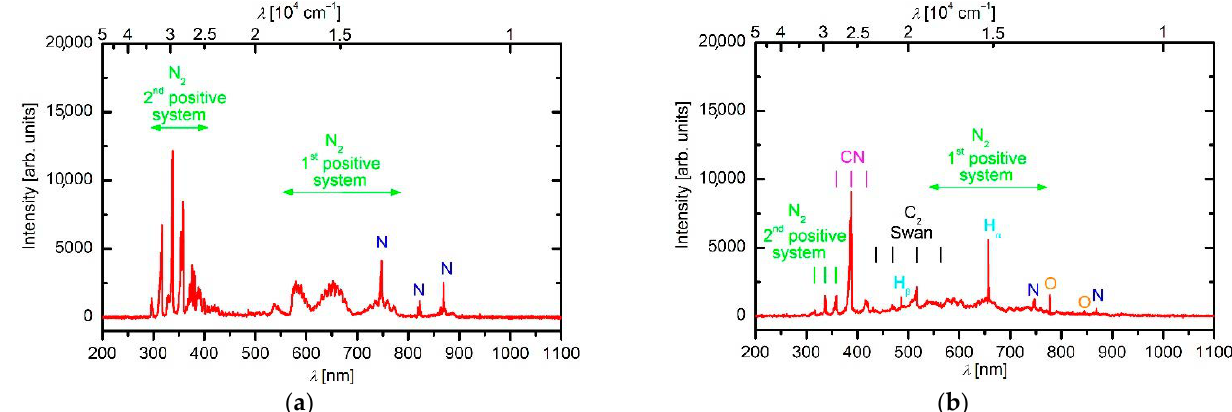
Figure 2. Optical emission spectroscopy (OES) spectrum of nitrogen plasma: ( a ) without any sample, and ( b ) during carbon nanomesh deposition.